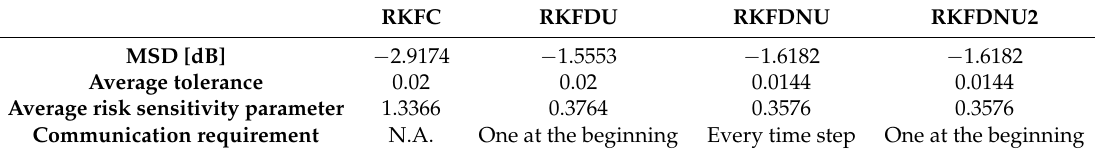
Table 1. Summary of the performance of the different algorithms with tolerance c =